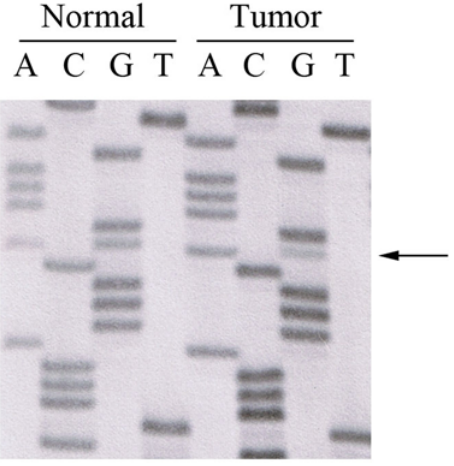
Figure 2. Sequencing results demonstrating loss of the wild- type EPHB2 allele in the G787R carrier. EPHB2 gene sequencing results of genomic DNA extracted from paired tumor and adjacent normal colon mucosa are shown. Relative to the intensities of the guanine bands in the sequencing reaction, the intensity of the guanine nucleotide at position 2359 is substantially reduced in the tumor sample, suggesting loss of the wild type allele (G) in the tumor but not in the adjacent normal tissue (arrow shows nt. 2359).